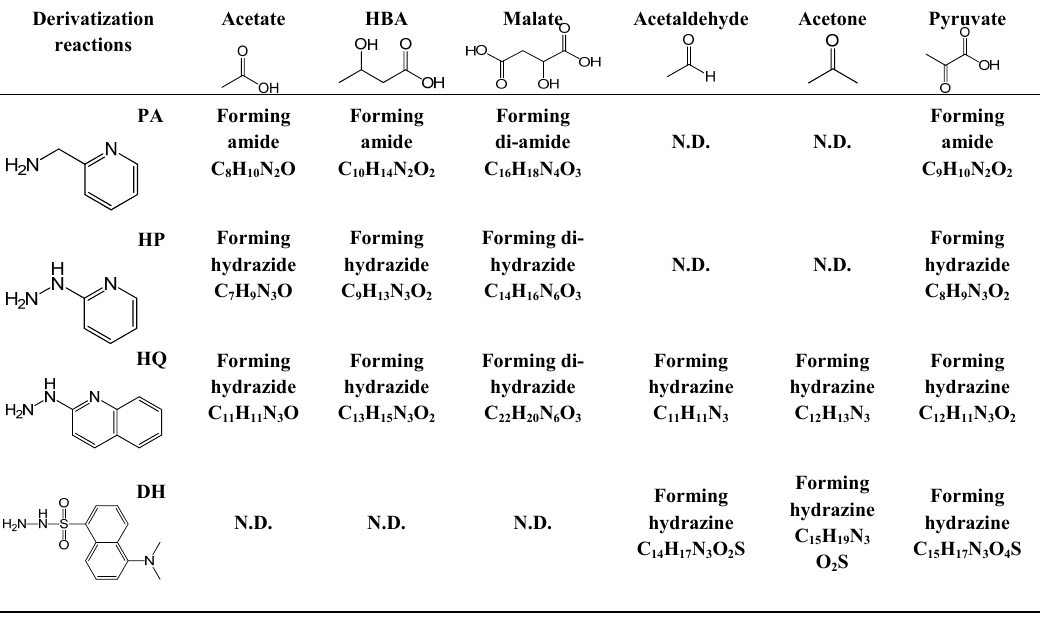
Table 1. The derivatization reactions and the molecular formula of derivatization products between derivatization agents (2-picolylamine (PA), 2-hydrazinopyridine (HP), HQ, dansyl hydrazine (DH)) and a mixture of acetic acid, 3-hydroxybutyric acid (HBA), malic acid, acetaldehyde, acetone and pyruvate. The structures and MS/MS spectra of enlisted HQ derivatives are presented in Figure 2. The structures of enlisted PA, HP and DH derivatives are presented in Supplemental Figure 1A–K. N.D. indicates that the derivative is not